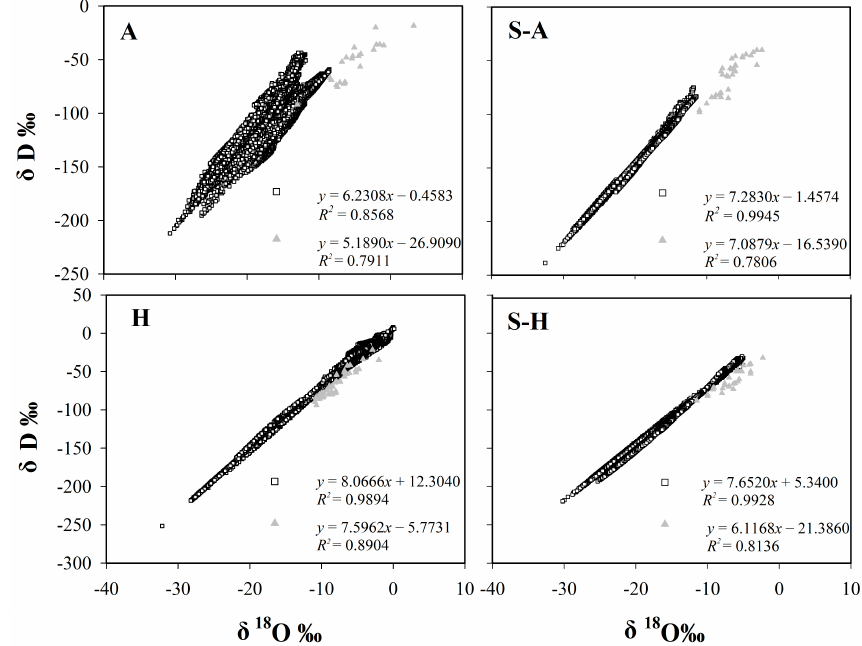
Figure 1. The relationship between δ D and δ 18 O values for precipitation and plant stem water. The hollow squares represent isotopic values for precipitation, the solid triangles represent isotopic values for plant stem water. A: Arid region; S-A: Semi-arid region; S-H: Semi-humid region; H: Humid region.